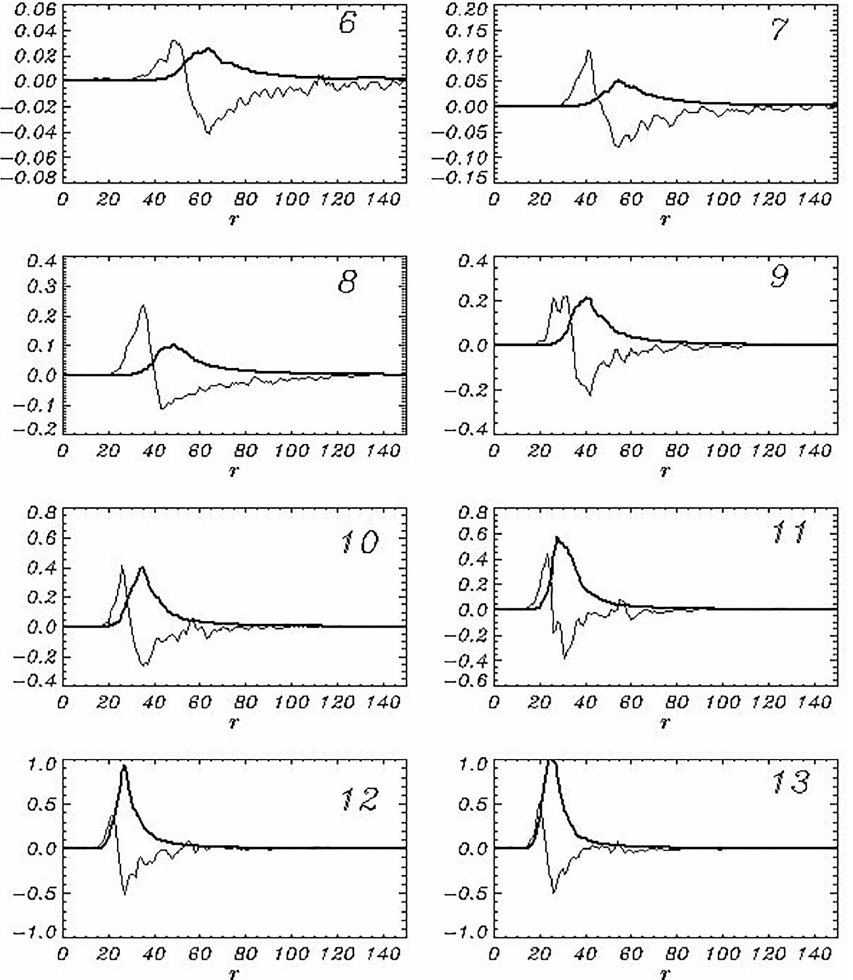
Figure 12. Sequence of wave spectra S h (r) (thick curves) and a nonlinear input term N (r) (thin curves) averaged over the eight consequent intervals of length (cid:49)t = 100 starting from the sixth period.